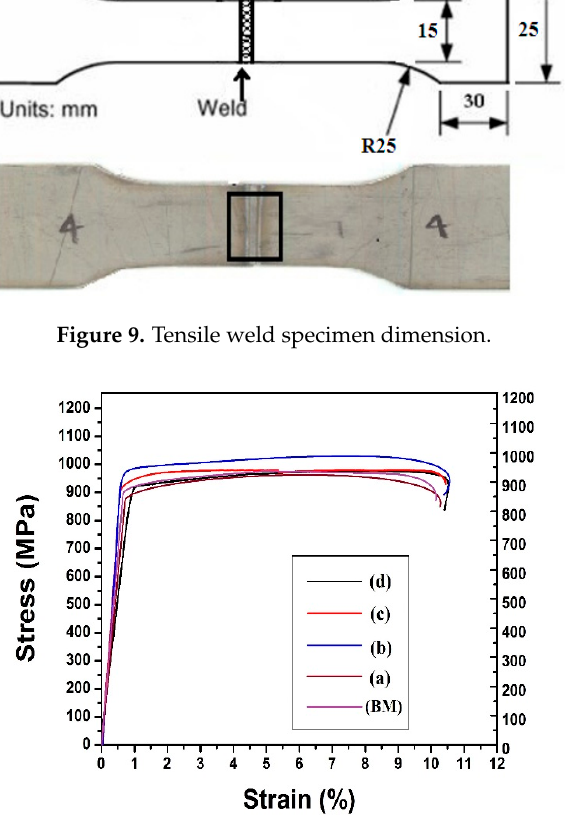
Figure 10. Stress strain curve of the welded joints at different parameters.